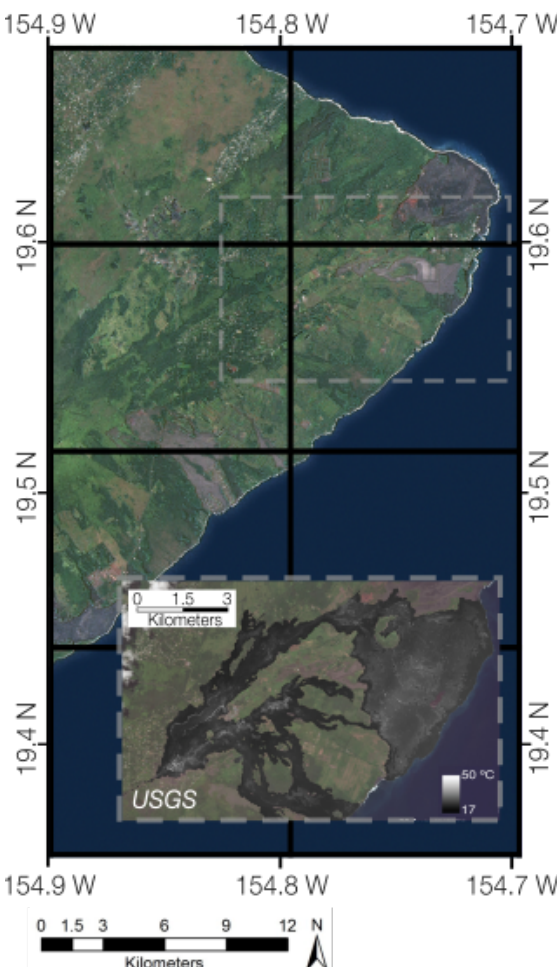
Figure 2. Landsat 15 m observation of the Kilauea Lower East Rift Zone before the 2018 eruption. Black grid represents the extent of the 9 km grid to which SMAP data are resampled in L1C products; each plot of Figure 3 represents the time series for each of these bins. Inset image shows thermal activity of the flows on 29 August 2018 (Credit: USGS and DigitalGlobe2019)